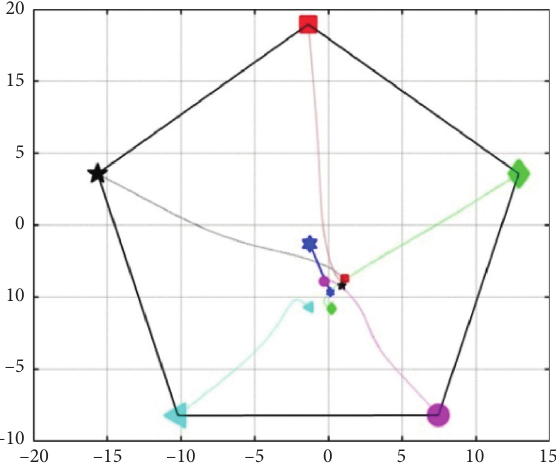
Figure 5: State trajectories of each agent for the leaderless case. Figure